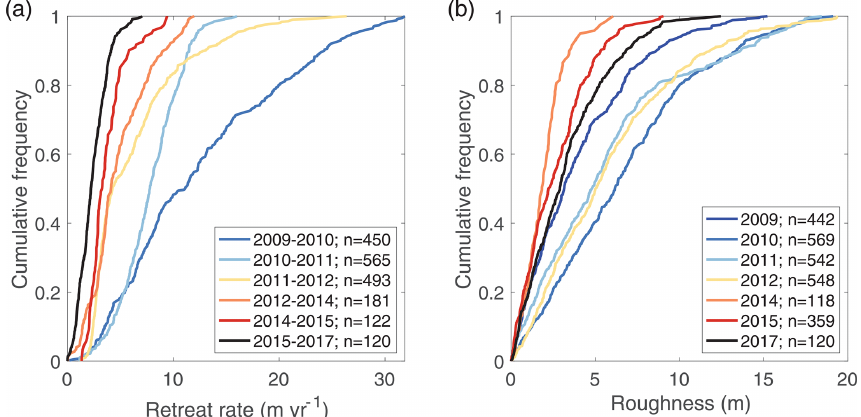
Figure 5. (a) Cumulative distribution function of retreat rate for each time interval. (b) Cumulative distribution function of cliff roughness for each time